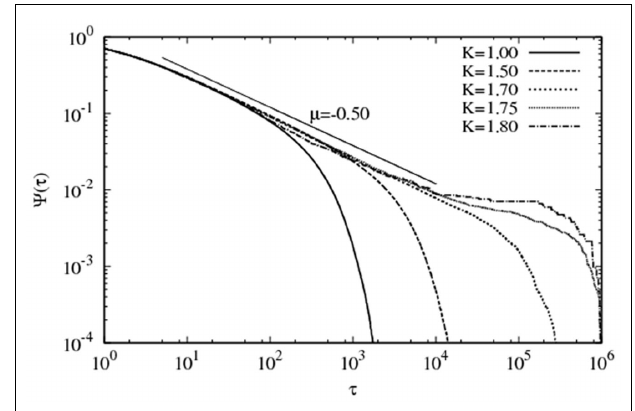
FIGURE 3 |The phase diagram for the global variable ξ eq . The thin solid line and dashed line are theoretical predictions for the fully connected and 2D regular networks, respectively. In both cases L =∞ and the latter case is the Onsager prediction for a 2D regular lattice.The thick solid line corresponds to the global states observed for a 2D regular lattice with L = 100 and g 0 = 0.01. Periodic boundary conditions were applied. (From Turalska et al., 2011, with permission.)